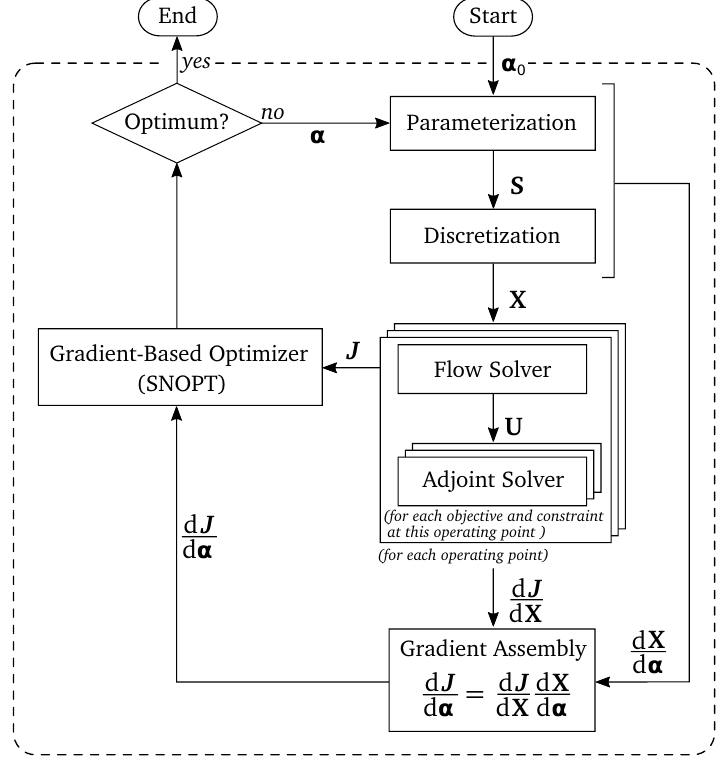
Figure 1. Flowchart of the gradient-based optimization